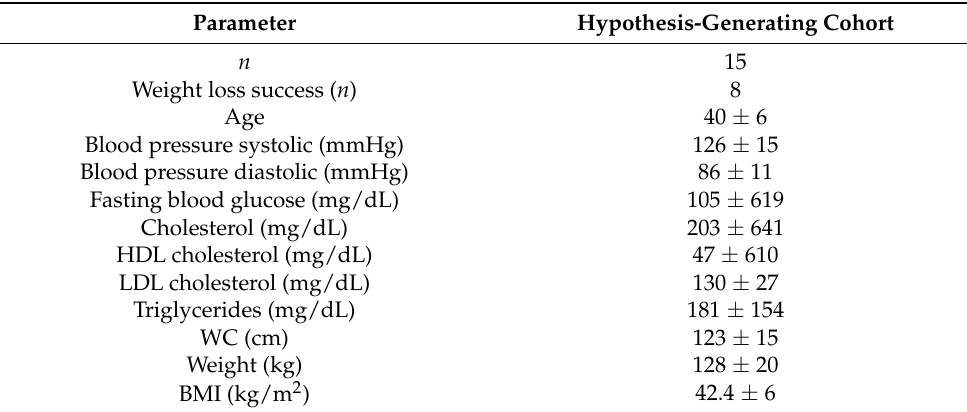
Table 1. Characteristics of the study